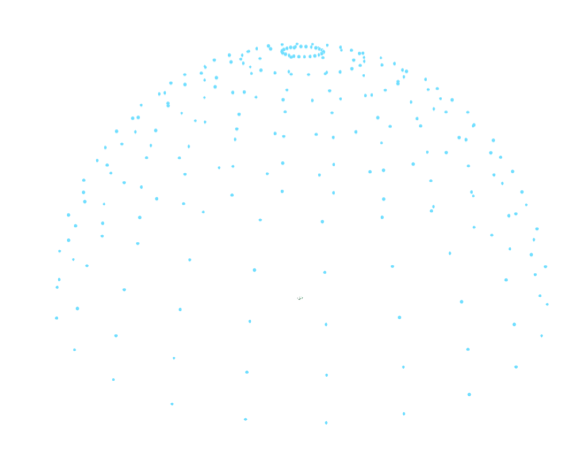
Figure 2. Constructed hemisphere showing centre-points of sky map